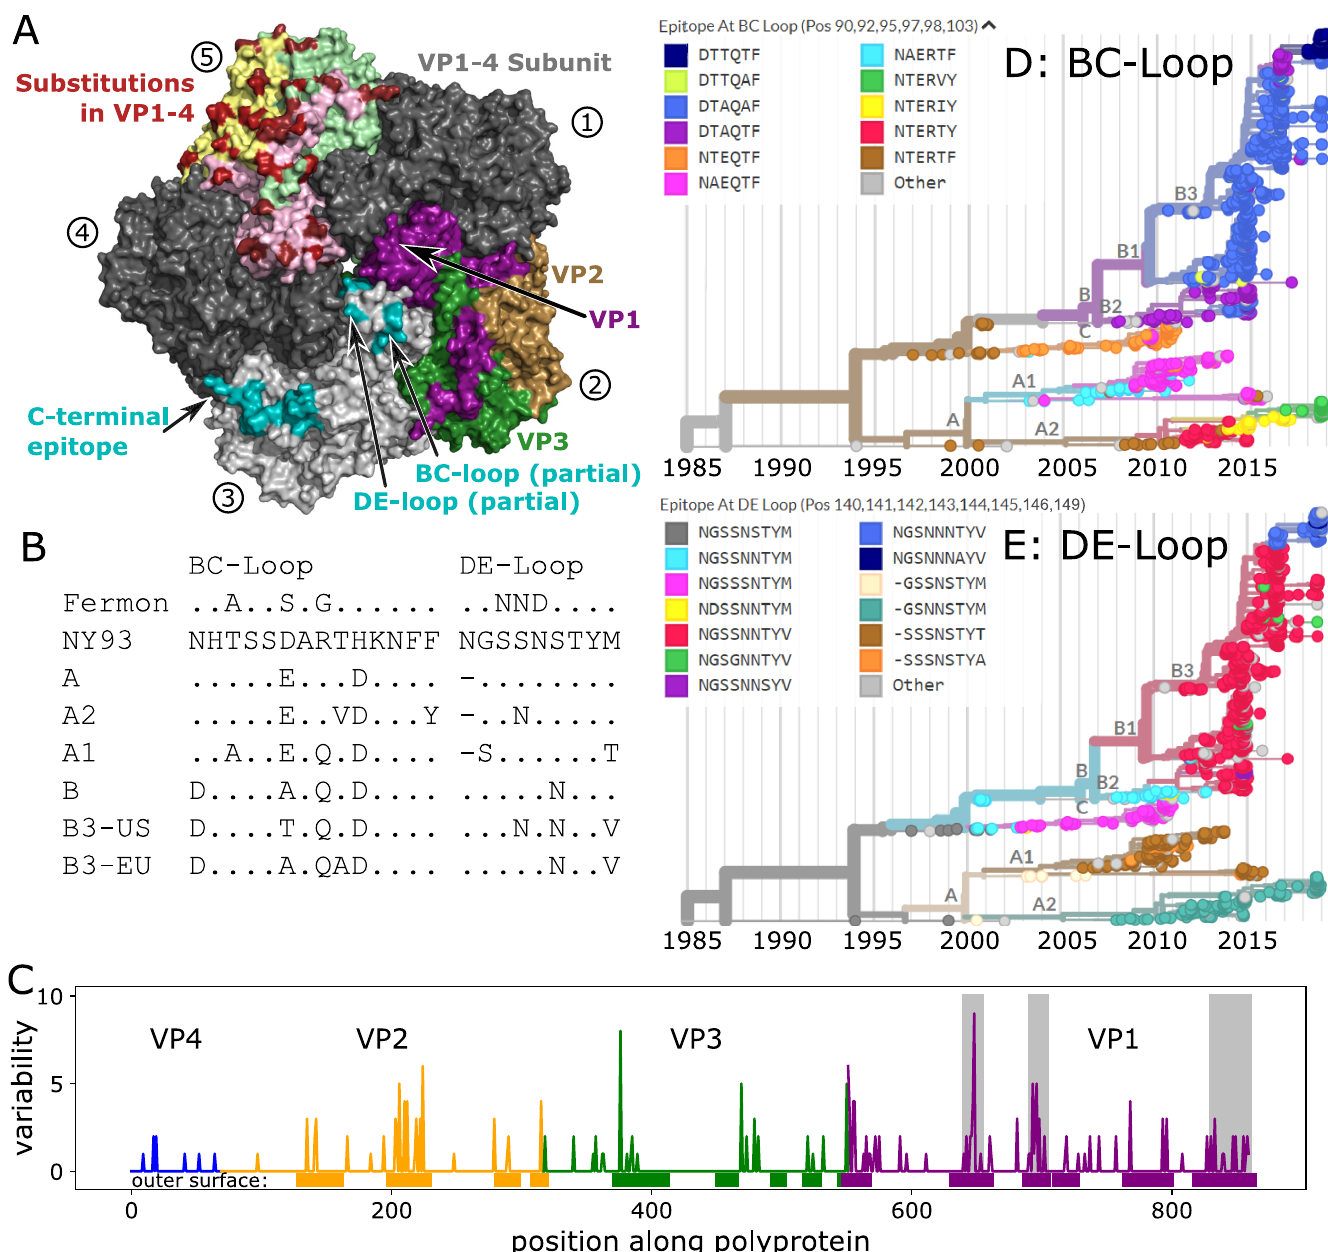
Fig 4. Molecular evolution of the EV-D68 capsid. Panel A) Rendering of 5-fold symmetric arrangement of the crystal structure of the capsid protomer consisting of VP1, VP2, VP3 and VP4 [41], using different copies of the protomer to highlight different aspects of the capsid organization, evolution, and immunogenicity. The five subunits are labelled 1–5 (circled numbers). Subunits 1 and 4 are present in dark grey to complete the structure. Subunit 2 shows the surface exposed proteins in purple (VP1), sand (VP2), and green (VP3), subunit 3 displays the different putative epitopes [42] (note that the most variable parts of the BC- and DE-loops are not shown, as their structure is not resolved), and subunit 5 highlights variable positions in red, with the different proteins forming the surface indicated by pale colors. Panel B) The hypervariable BC- and DE-loops (partly missing from the structure in Panel A) in clusters and subclusters accumulated multiple changes since the root of the tree (the inferred root sequence patterns match those of the NY93 strain shown here). (BC-loop is AA positions 90–103; DE-loop is AA positions 140–148). Patterns for the C- terminus and a region of VP2 are shown in S2 Table. Panel C) Variable positions often fall into surface exposed parts of the protein (Fisher exact test, OR = 6, p < 10 − 16 ). Genes are highlighted by blue (VP4), orange (VP2), green (VP3), and purple (VP1). Grey boxes show, from left to right, the BC- and DE-loops, and C-terminus regions. Panels D&E) Phylogenetic VP1 trees are colored by the most common epitope patterns of the 6 and 8 most variable amino-acid positions in the BC- and DE-loops, respectively. Particularly note-worthy is the rapid turnover of BC-loop variants in the recent evolution of the A2 subclade. Patterns for the C-terminus region are shown in S6 Fig. See S8 Fig for a zoomed version of panels D & E with cumulative AA changes.